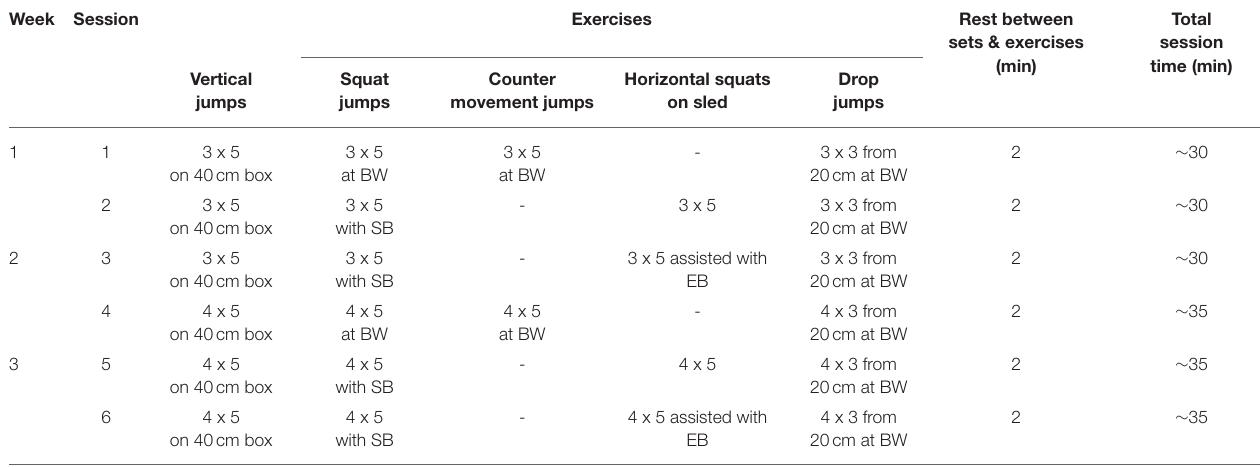
TABLE 3 | Plyometric training program distribution over the 3-week training. Week Session Exercises